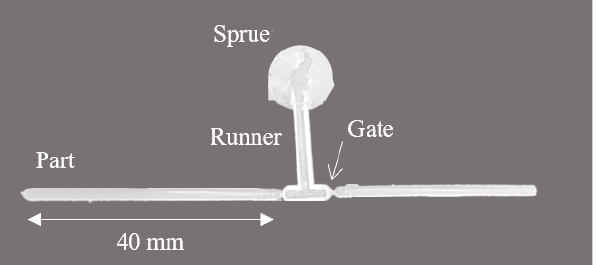
Figure 1. Injection-molded part geometry. A 2-cavity mold was used to fabricate rods 2 mm in diameter and 40 mm in length.